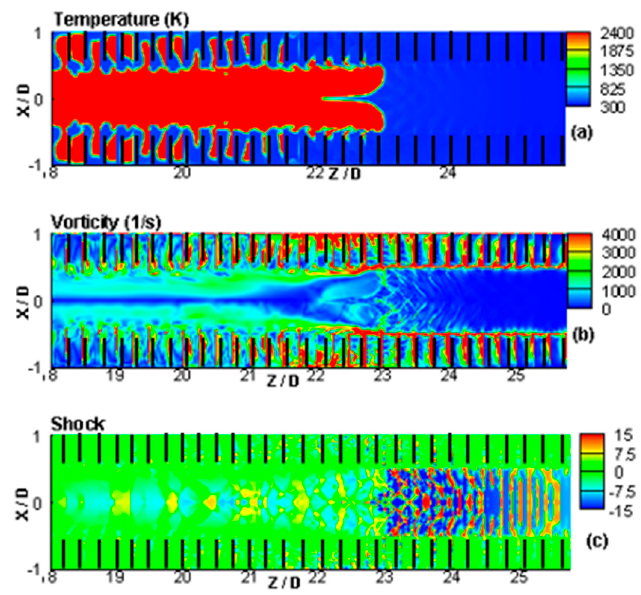
Figure 4. The characteristic instantaneous snapshots of the temperature ( a ), vorticity ( b ) and shock waves ( c ) taken at the acceleration phase of the evolution of a flame with the thermal expansion ratio Θ = 8 propagating in a channel with the blockage ratio α = 1/2.